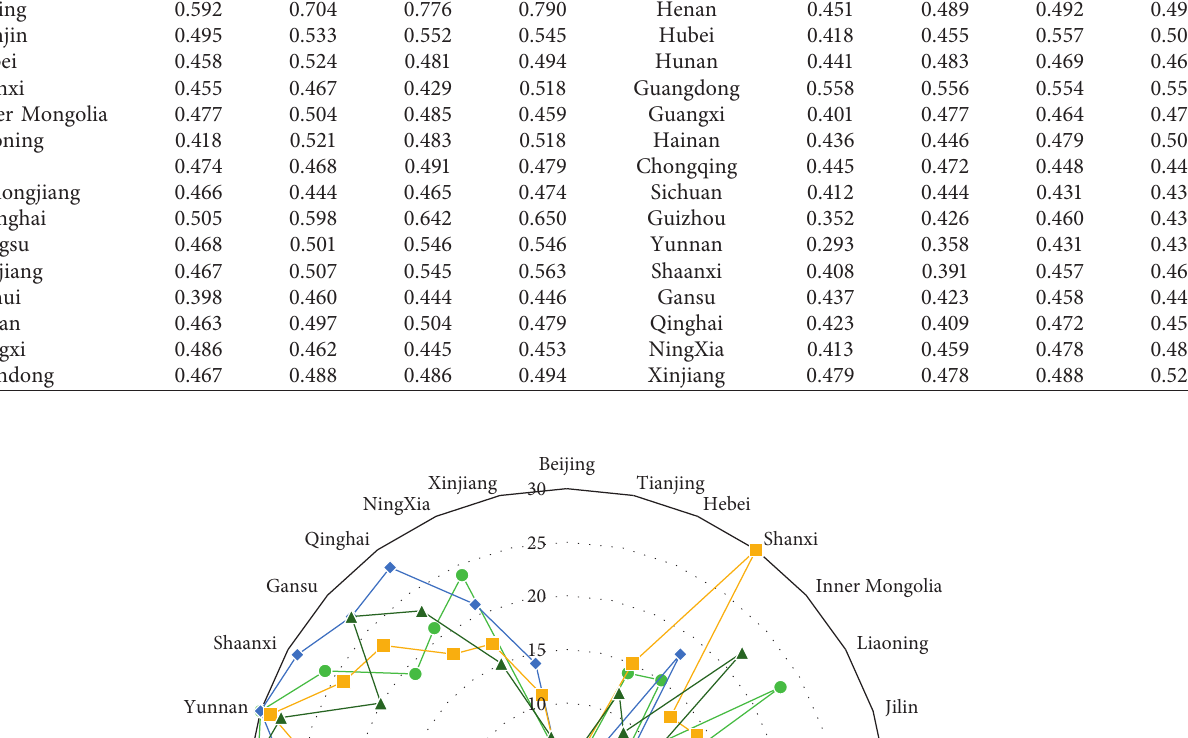
Table 5: The comprehensive index of EGQ subsystem in 2004, 2010, 2015, and 2017. Province